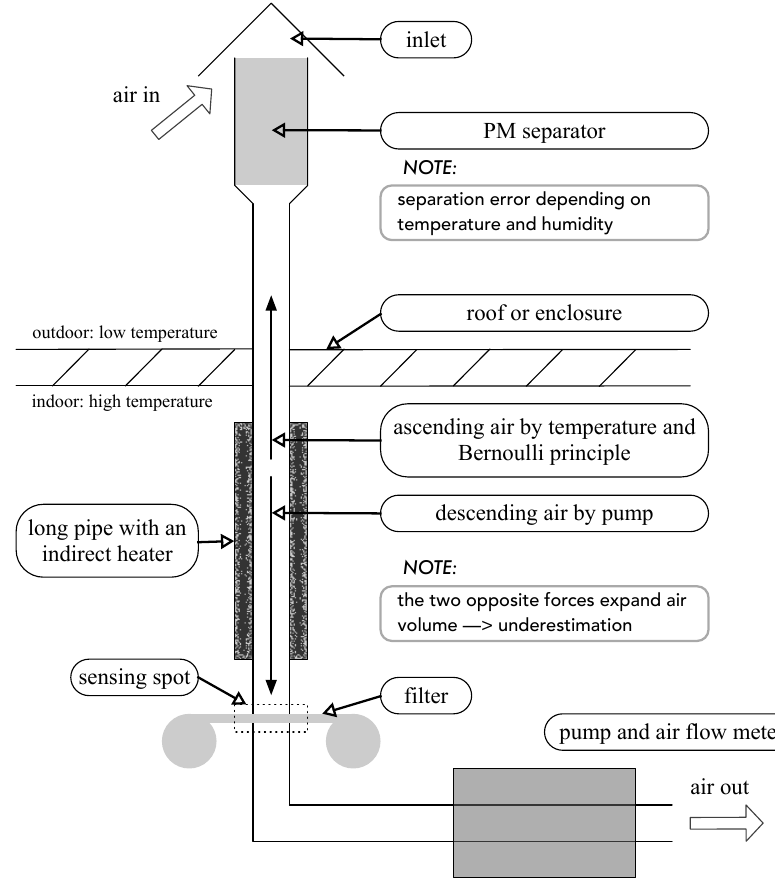
Figure 1. Diagram of a traditional